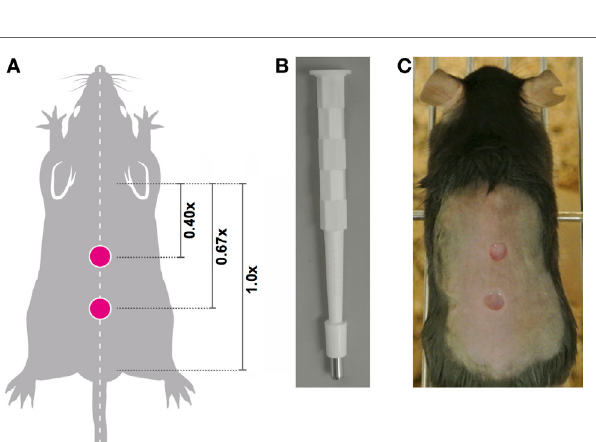
FIgURe 2 | Location of midline wounds. (A) The distance between the base of the ears equals a 1x distance. To ensure consistency in wound creation, two 4-mm, full thickness wounds were created at 0.4 × and 0.67 × the ear-to-tail distance in each animal. (B) 4-mm surgical punch biopsies were used to create full thickness wounds. (C) An anesthetized mouse with two midline wounds; image captured immediately post-wounding.